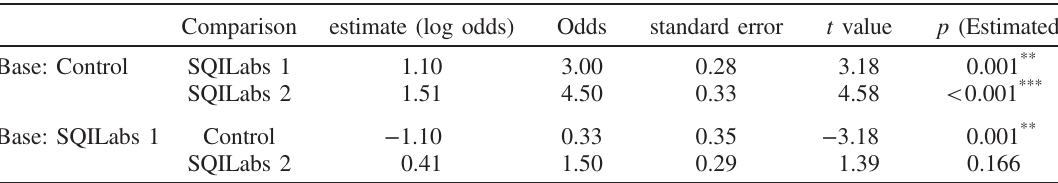
TABLE IV. Ordinal logistic regression table for students ’ follow-up on comparisons. Base comparison is the control group (in the top section) and SQILabs 1 (in the bottom section). p values are estimated from the